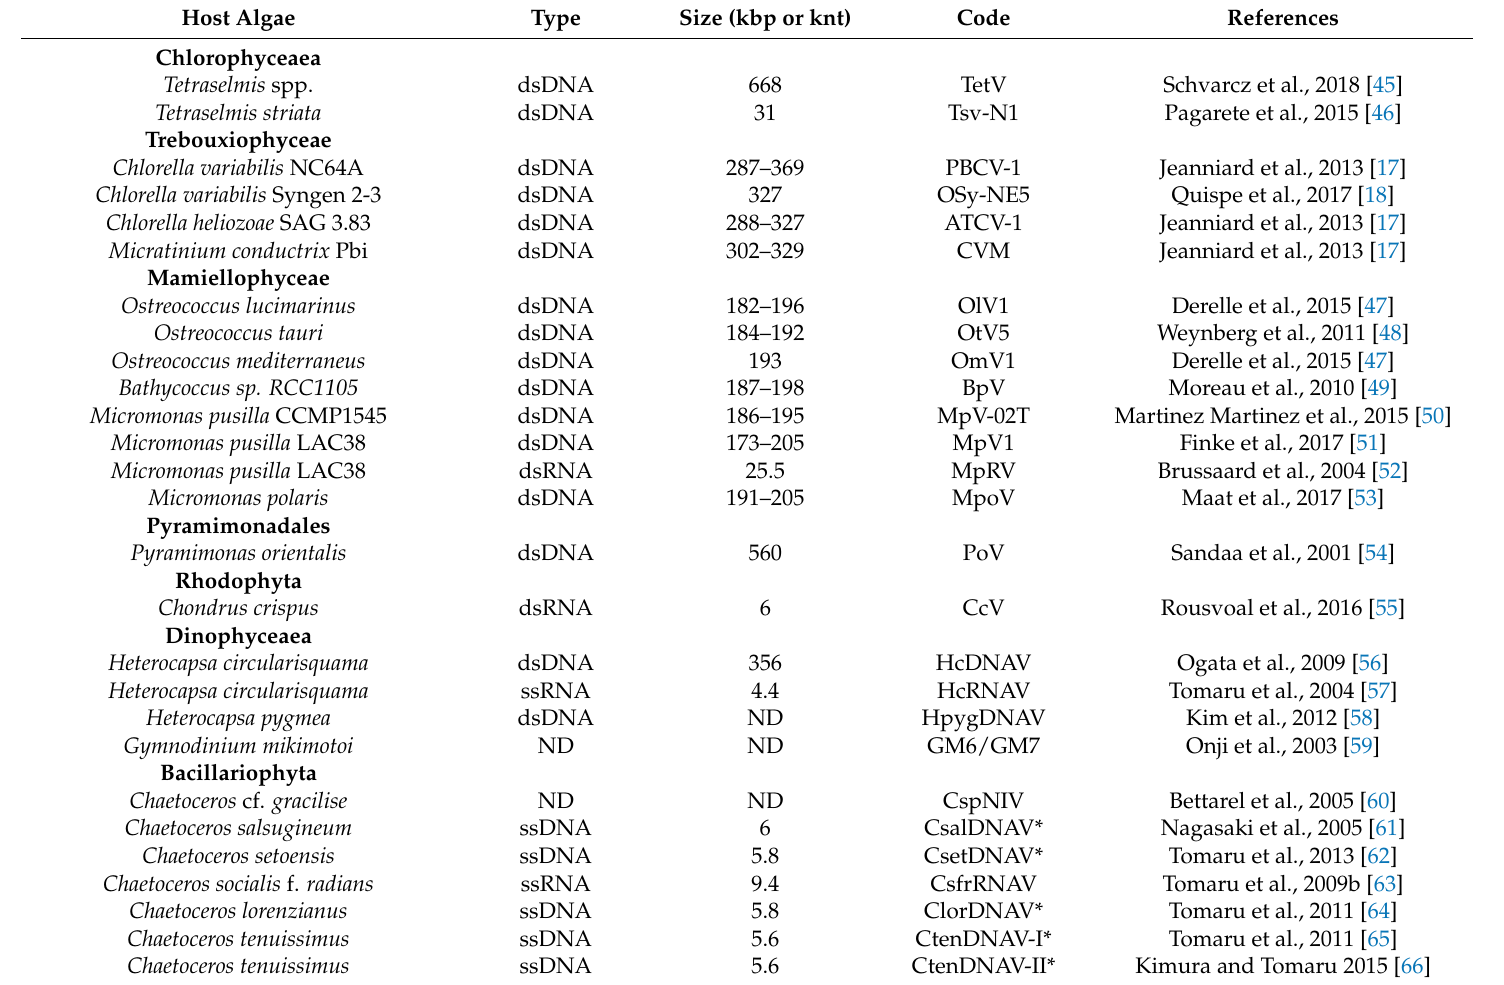
Table 1. Algal viruses currently in culture